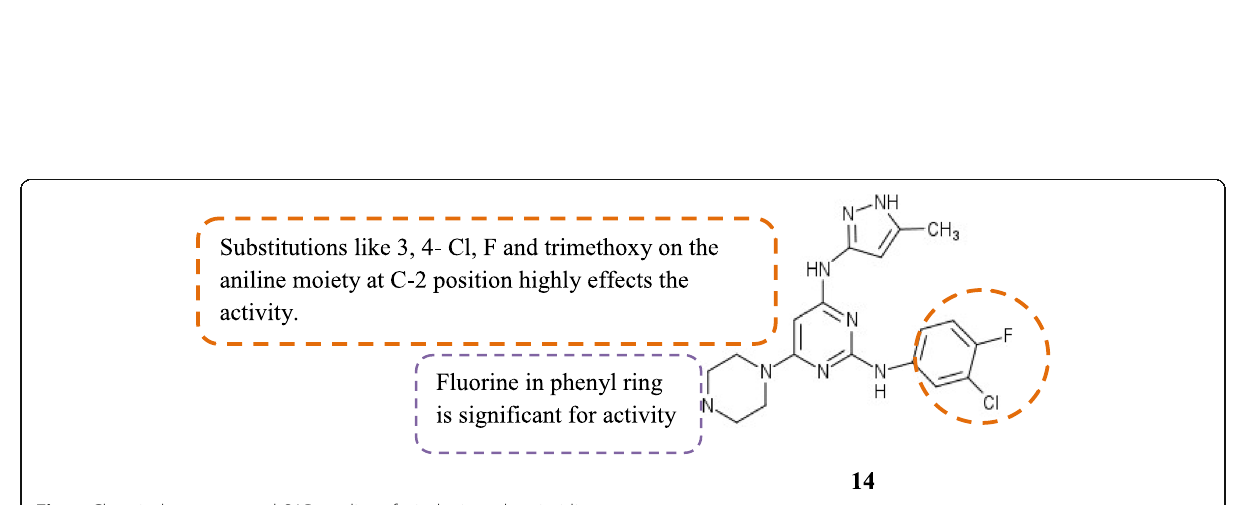
Fig. 5 Chemical structure and SAR studies of trisubstituted